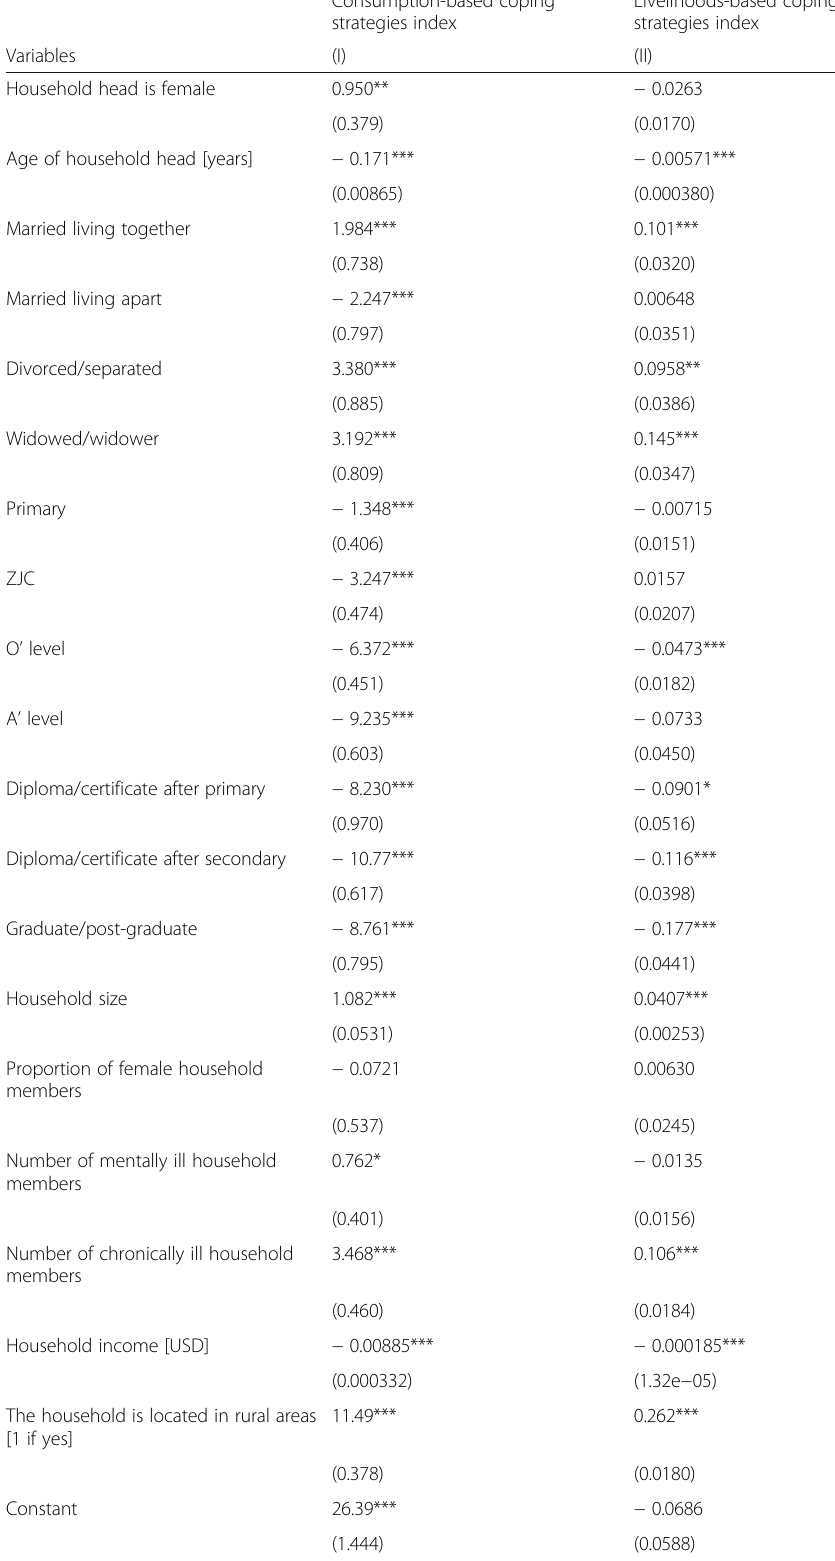
Table 6 OLS estimates of the impact gender on coping